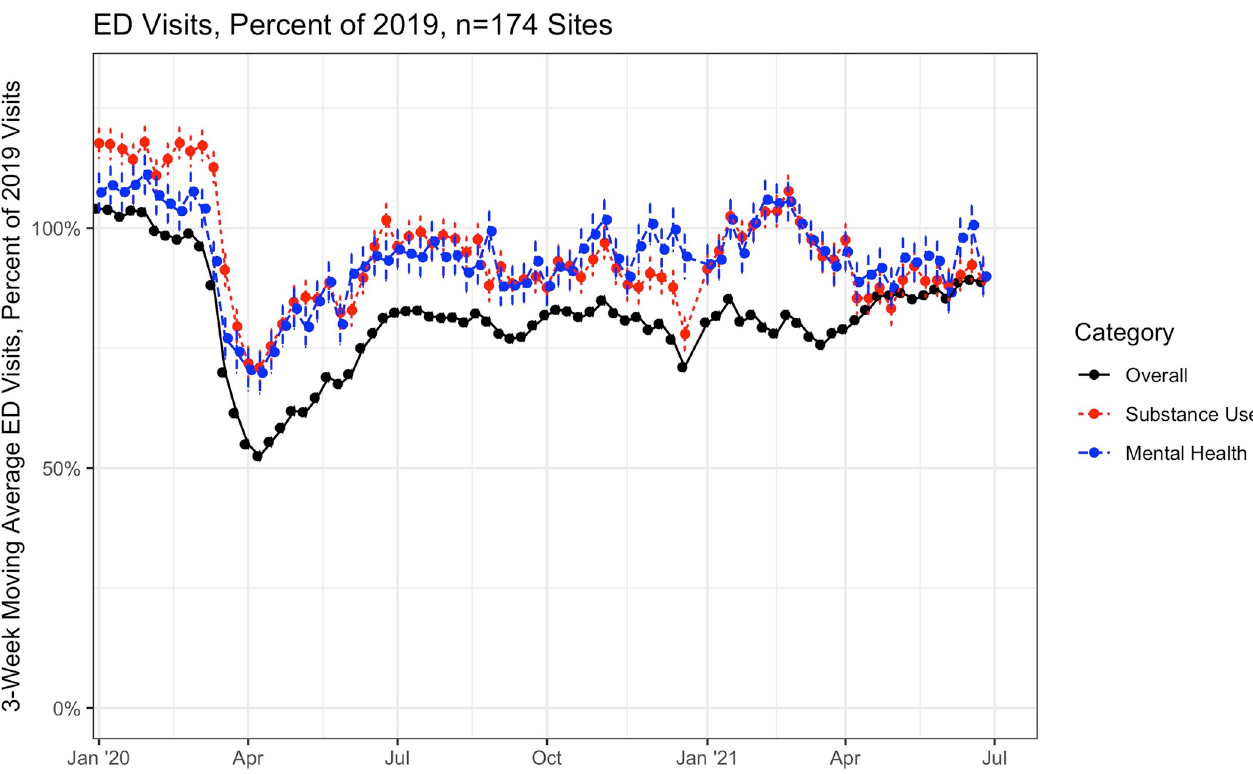
Fig 1. Trends in weekly ED visits for substance use disorders and mental health conditions, 2020. Notes: Figure depicts 3-week moving average ratio of emergency department visit counts in 2020 and 2021 compared to identical weeks in 2019. Sample includes 174 hospital-based EDs across 33 states from a national emergency department clinical quality registry. Visits for substance use disorders and mental health conditions were identified by International Classification of Disease -10